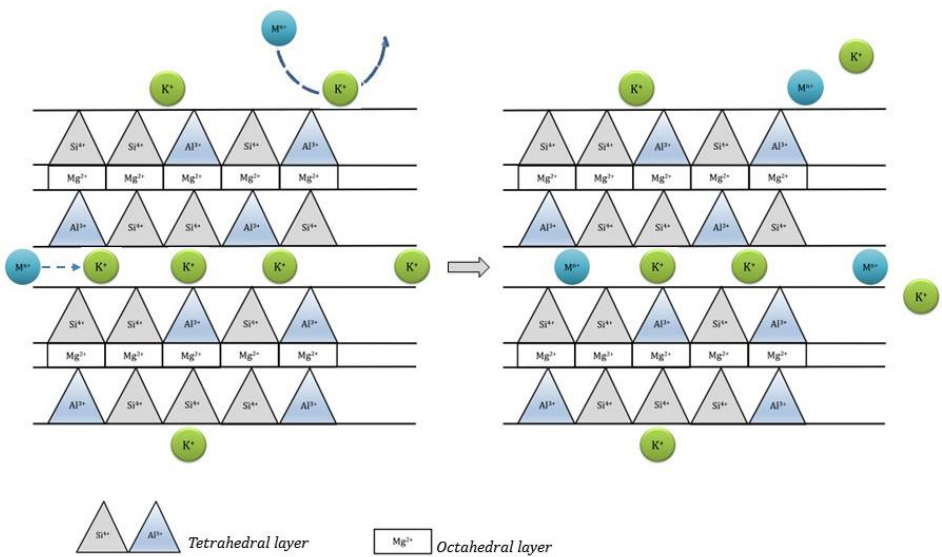
Figure 9. Schematic presentation of sorption mechanism of metals by illite.